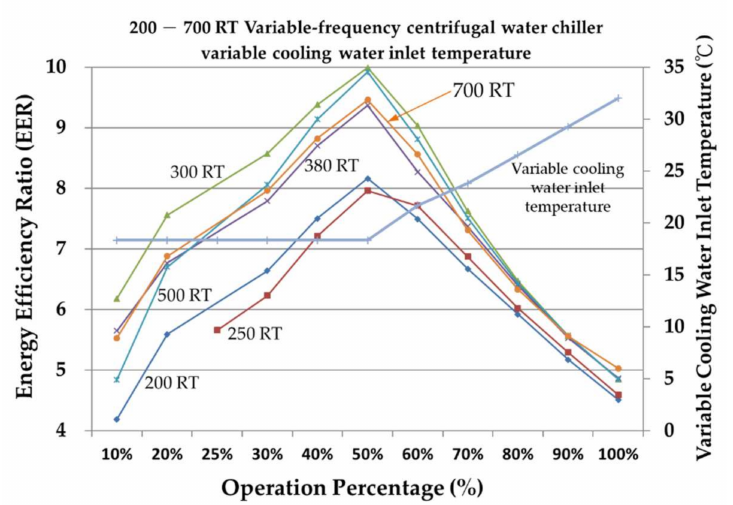
Figure 16. Variable-cooling water inlet temperature EER of the 200–700 RT variable-frequency water